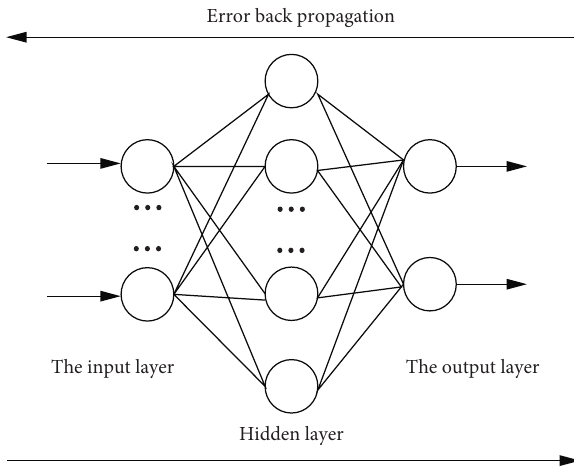
Figure 1: Basic structure of BP neural